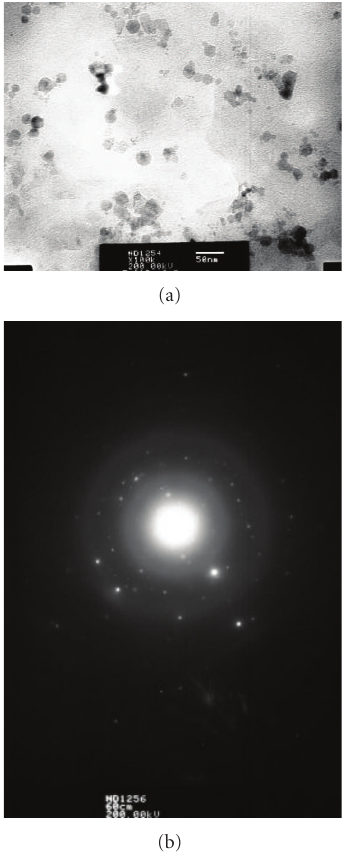
Figure 3: TEM micrograph of composites containing 1.5phr of fullerene (a) and a selected area electron di ff raction (SAED) micro- graph